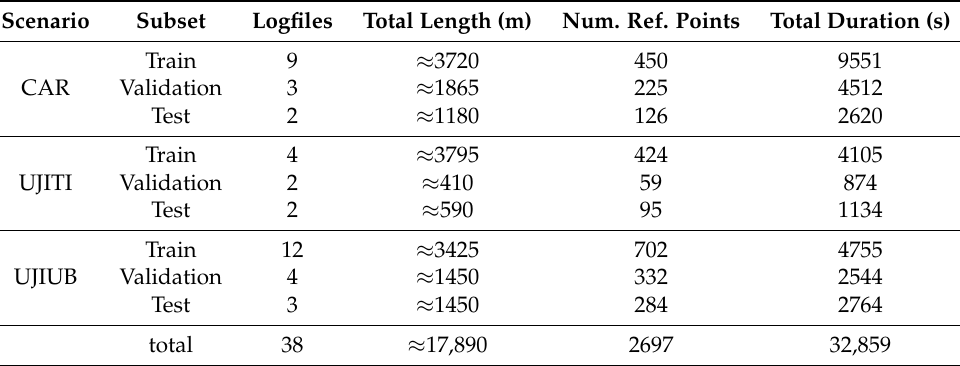
Table 1. Resume of the logfiles provided to 2017 IPIN competitors.